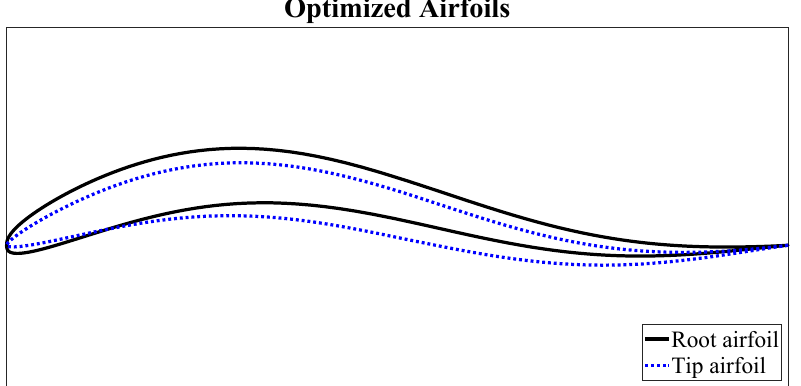
Figure 8. Optimal root and tip airfoil